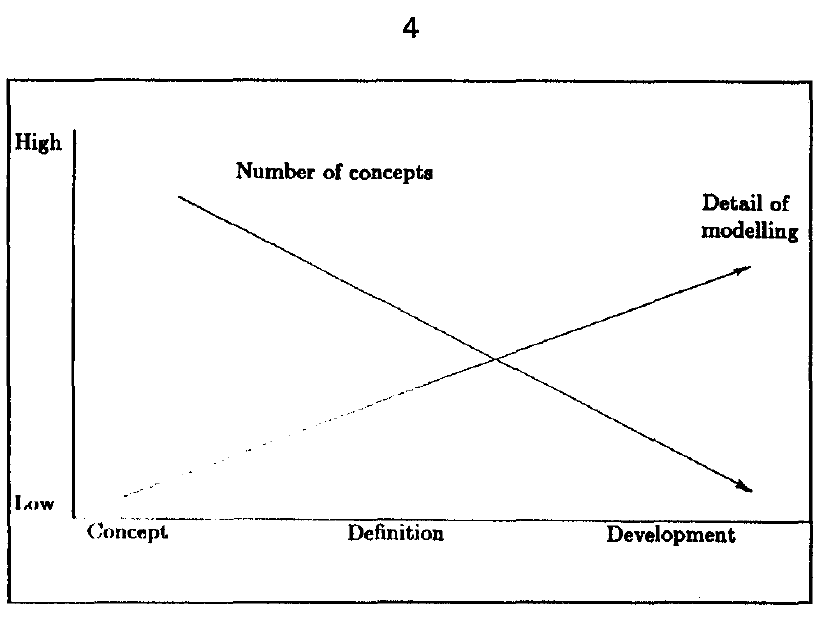
Figure 1 : Number of concepts vs Detail of modelling